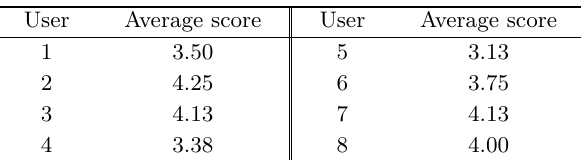
Fig. 10 Comparison between our method and that of Shilkrot et al.: (a) user image, (b) library image, (c) our result, and (d) their result. Table 1 Average scores awarded by users